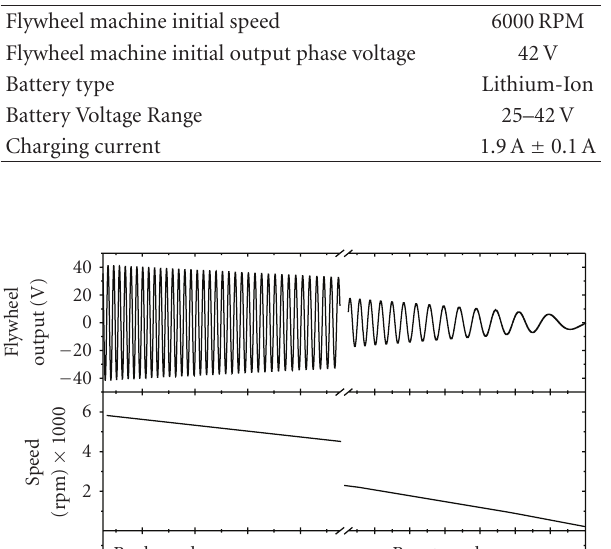
Table 1: Parameters of the system used in the DC/DC converter simulation.